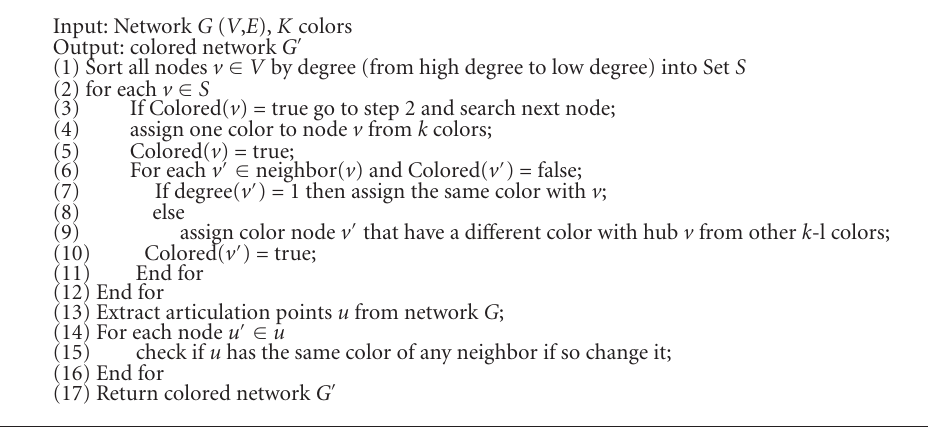
Algorithm 1: The pseudocode of the color-coding method.